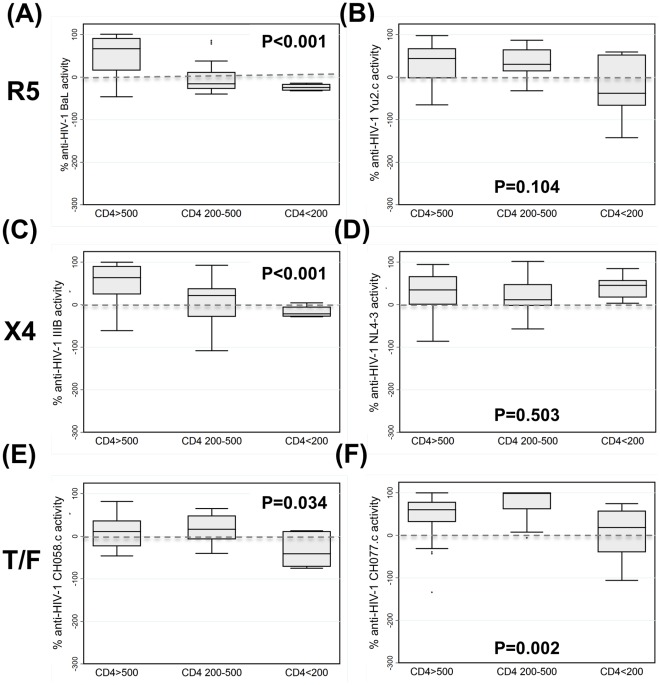
HIV disease progression exerts a selective impact on anti-HIV activity of cervicovaginal lavage fluid.HIV disease progression to CD4 counts <200 was associated with significant reductions in anti-HIV activity against the R5-tropic virus BaL (A) but not Yu2.c (B), on one of two X4 tropic viruses IIIB and NL4.3 (C &D), and against both transmitted/founder (T/F) viruses CH058.c or CH077.c (E & F). Negative anti-HIV activity values indicate enhancement of infection. Bars depict median, interquartile range and 95% confidence intervals; P values derived via Kruskal-Wallis tests.